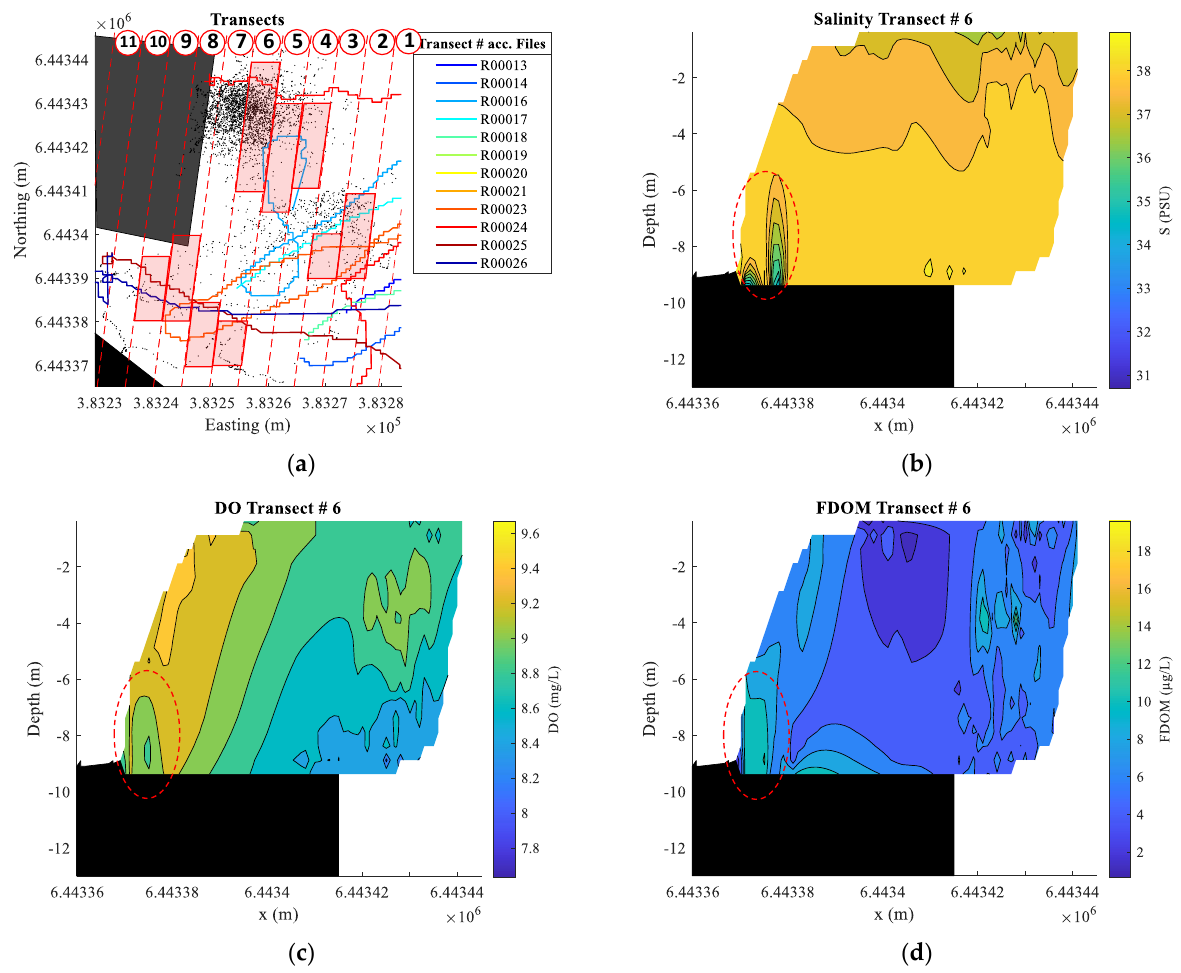
Figure 14. ( a ) Transect overview for spatial investigation, including data points from in situ measurements (black), sonar transect paths, and potential SGD areas identified from spatial distribution plots given in Figure S3 (red polygons); ( b ) spatial distribution of salinity values in transect number 6 including area of interest (red dashed line); ( c ) spatial distribution of DO values in transect number 6 including area of interest (red dashed line); ( d ) spatial distribution of FDOM values in transect number 6 including area of interest (red dashed line).